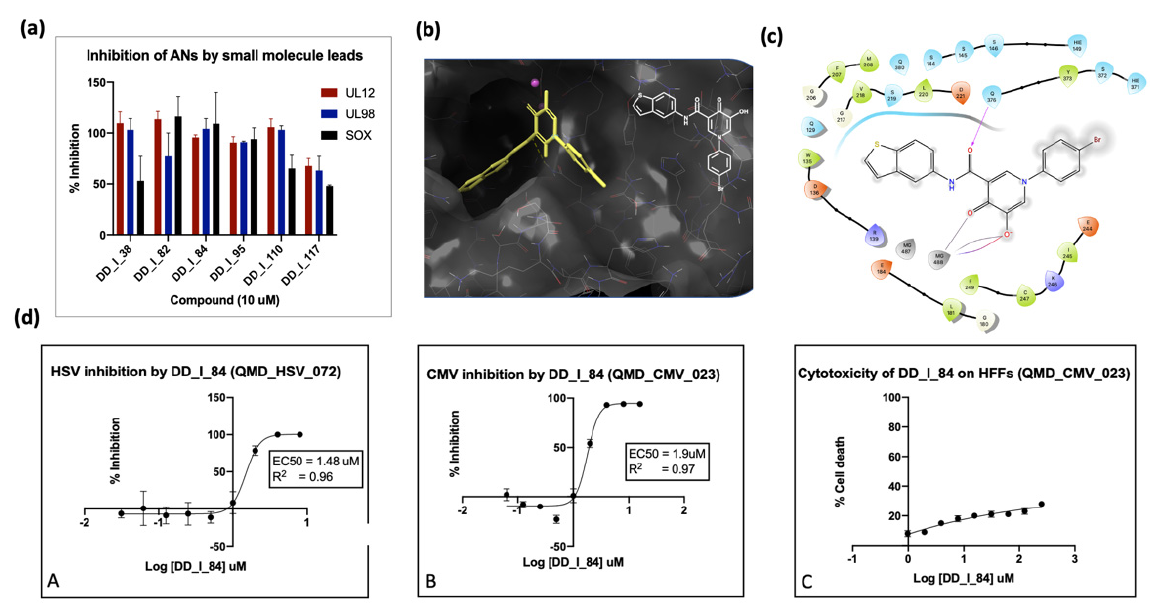
Figure 6. ( a ) Small molecule inhibition of HHV ANs from HSV, CMV and KSHV; ( b ) docking of compound 3 to SOX active site; ( c ) lig plot showing key interactions of the inhibitor and active site residues; ( d ) cytotoxicity and antiviral activity of compound 4 against HSV and CMV and relevant cytopathic effect against HFF cells.